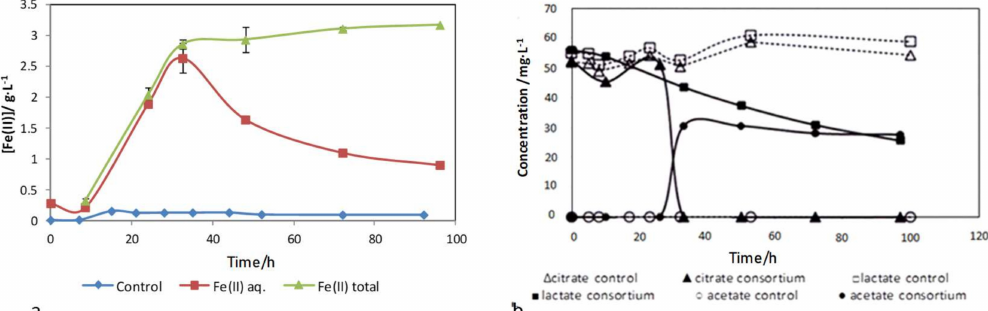
Figure 1. ( a ) Production of soluble and total Fe(II) by the natural consortium and ( b ) lactate, citrate and acetate concentrations in solution during the microbial reduction of ferric citrate provided as a sole iron source at 60 mM. All Fe(II) measurements were performed in duplicate by the ferrozine method and the standard deviation (n = 2) is shown for each data point. Error bars not visible are smaller than